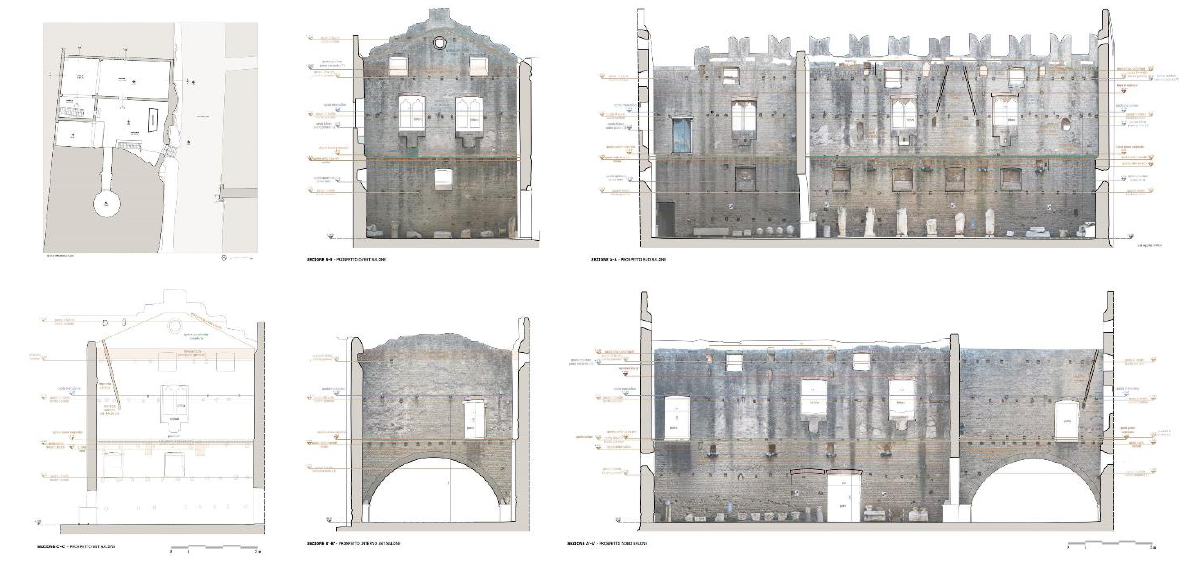
Figure 8. As-found 2D CAD Drawings and Building archaeology